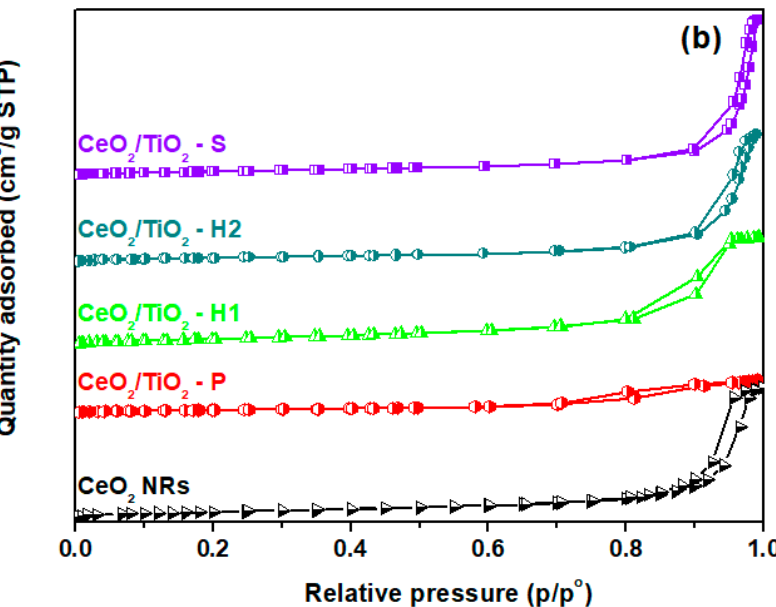
Figure 1. ( a ) BJH desorption pore size distribution; ( b ) adsorption-desorption isotherms of bare CeO 2 and CeO 2 /TiO 2